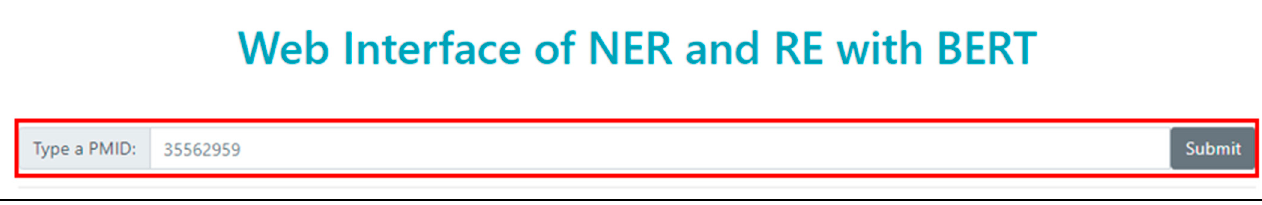
Figure 7. First screen on our website.